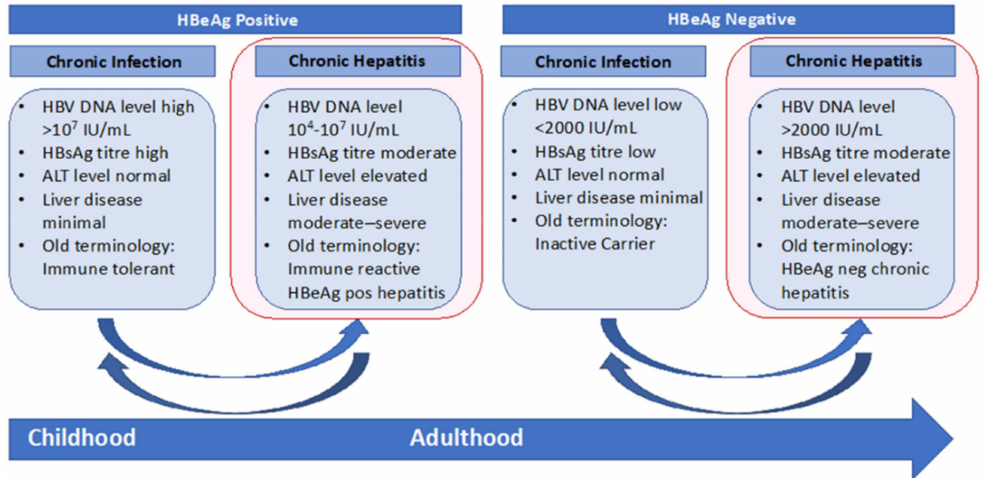
Figure 2. Natural history and clinical characteristics of the phases of chronic hepatitis B infection. Current international hepatitis B management guidelines have di ff erent criteria for initiating